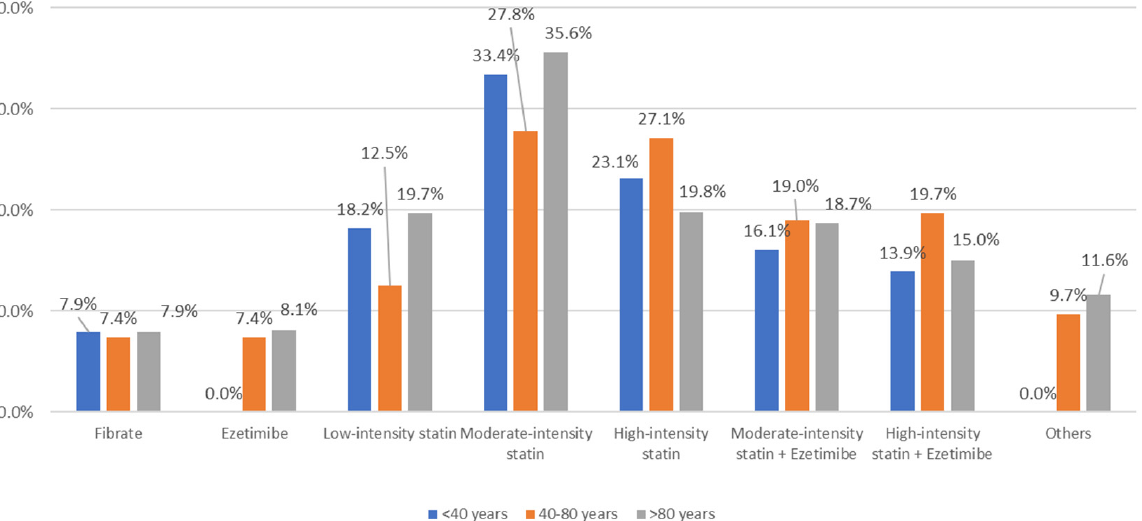
Figure 1. Pharmacological treatment considered by physicians for use in patients with dyslipidemia by age.